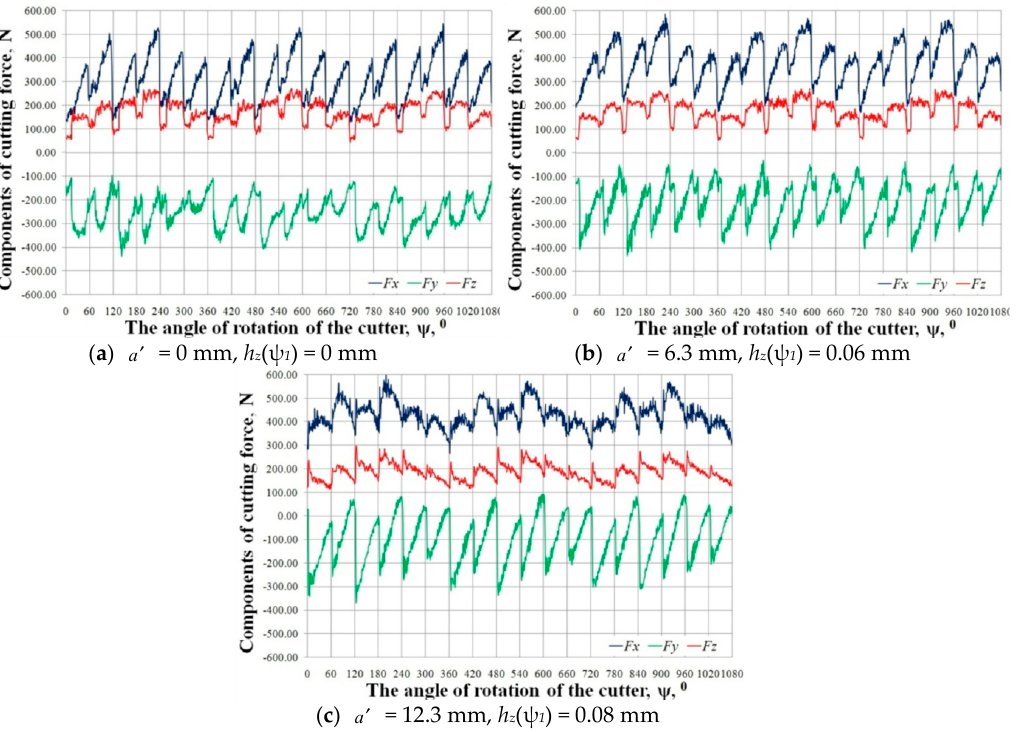
Figure 3. The cutting force components’ time courses.